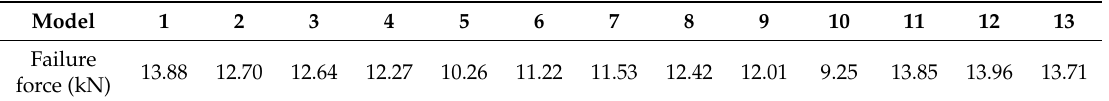
Figure 4. Force–displacement graphs for pure adhesive joints. Table 4. Failure force of adhesive joints.